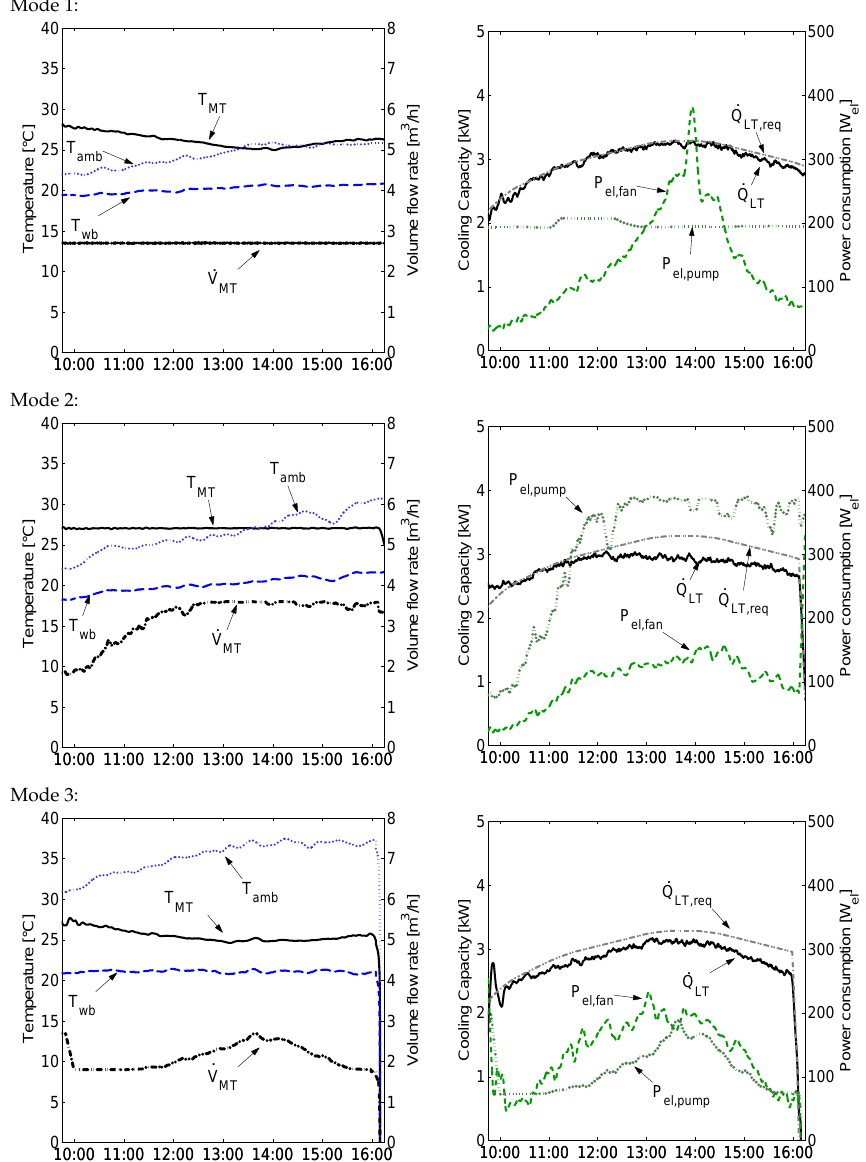
Figure 5. Results of the three control strategies on different days with comparable conditions ( T wb around 19–21 ◦ C). On the left side, the ambient conditions ( T amb and T wb ) and the set point variables T MT and ˙ V MT of the heat rejection circuit are drawn. The plots on the right side show the measured electrical consumptions ( P el , fan and P el , pump ), the virtual cooling load ˙ Q LT , req and actual chilled cooling capacity ˙ Q LT